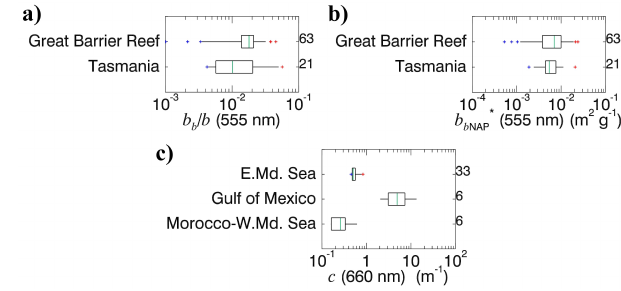
(m 2 g − 1 ) and bNAP